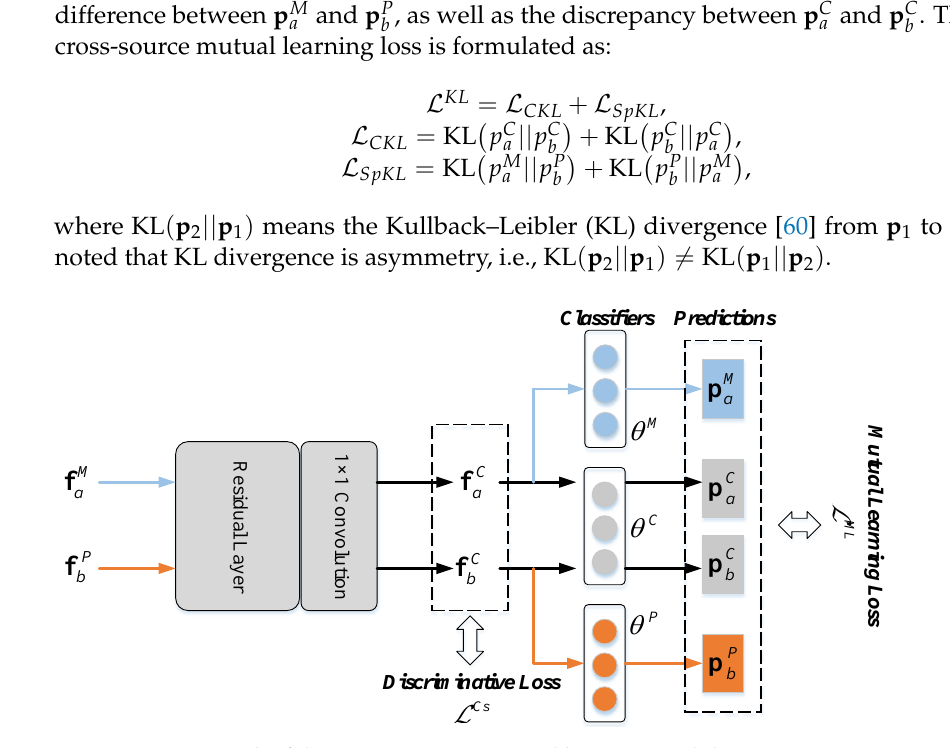
Figure 2. Framework of the common space mutual learning